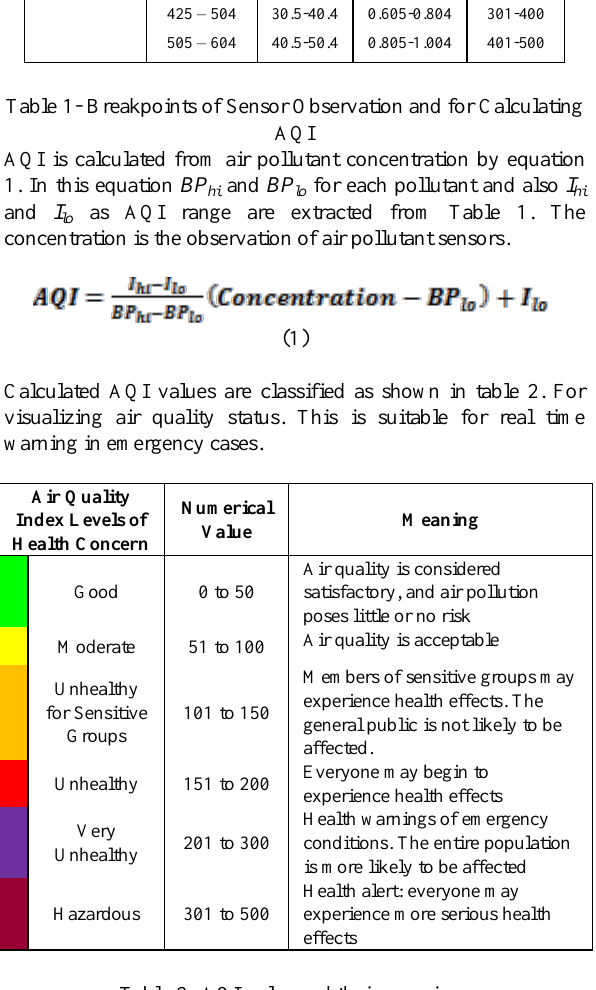
Table 2- AQI color and their meanings